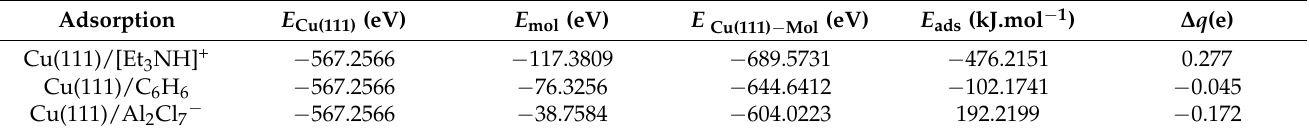
Table 2. The adsorption energy total charge transfer ( ∆ q ) of [Et 3 NH] + , Al 2 Cl 7 − and C 6 H 6 on Cu(111).